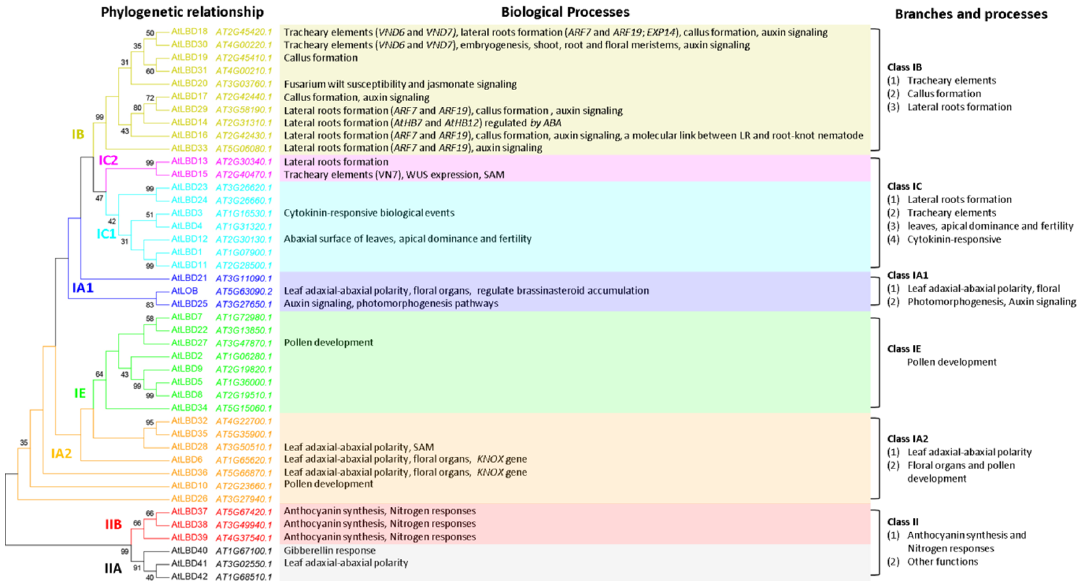
Figure 2. Phylogeny and functions of Arabidopsis LBD proteins. The phylogenetic tree was reconstructed in MEGA6 using aligned protein sequences of LOB domain regions in Arabidopsis by ML method with JTT model and Nearest ‐ Neighbor ‐ Interchange (NNI) heuristic searches based on an NJ (neighbour ‐ joining) initial tree. Support values (>30) are shown next to the nodes. The colors of branches and gene names correspond to those in Figure 1. correspond to those in Figure